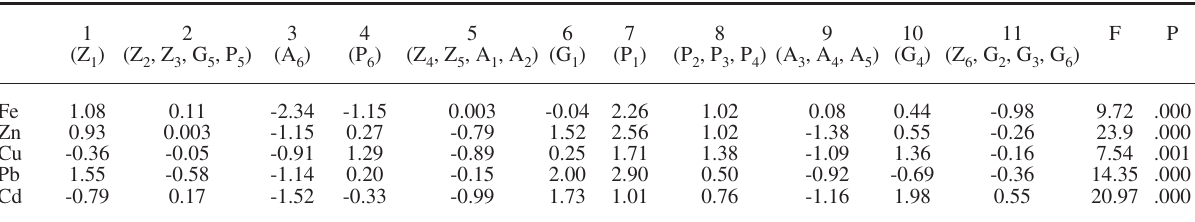
Table 6. – Wet-weight class classification for the method K-means with K = 11 clusters and one-way anoVa for each metal. the weight class corresponding to the clusters is shown in